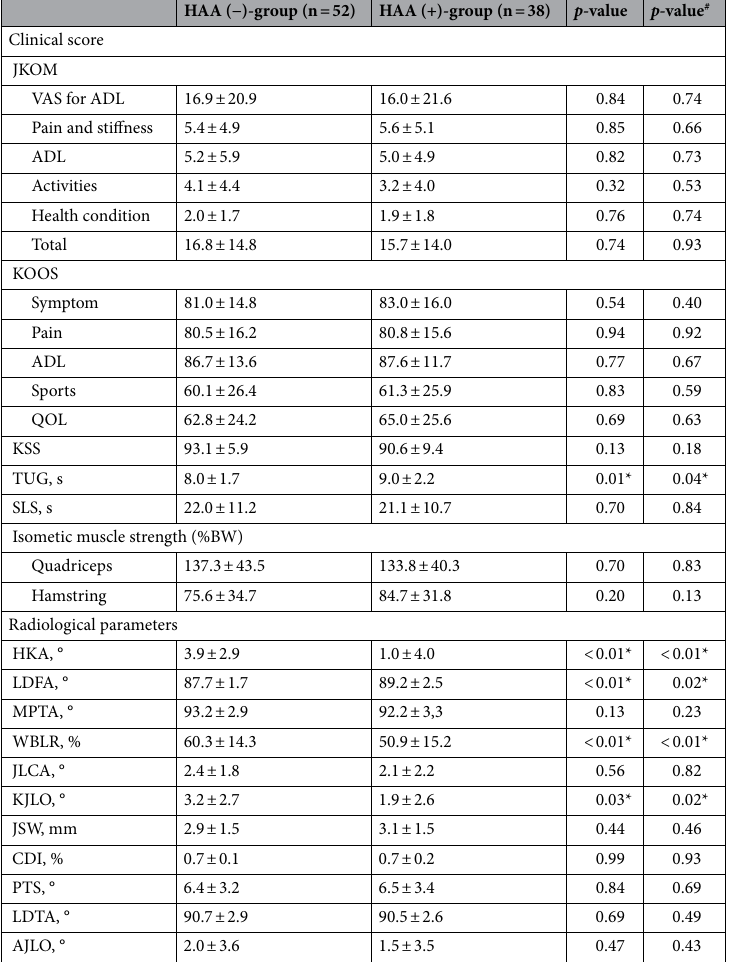
Table 3. Comparison of Clinical and functional score and radiographic parameter between HAA (−) group and HAA (+) group at 2 year post-operation. Data are shown as the means with standard deviation or number. JKOM Japanese Knee Osteoarthritis Measure, VAS visual analogue scale, ADL activities of daily living, KOOS knee injury and osteoarthritis outcome score, QOL quality of life, KSS Knee Society Score, TUG timed up and go test, SLS single leg stance, HAA hip abduction angle, HKA hip-knee-ankle, FTA femoro-tibial angle, WBLR weight-bearing line ratio, JSW joint space width, PTS posterior tibia slope, CDI Caton-Deschamps index, MPTA medial proximal tibial angle, LDFA lateral distal femoral angle, LDTA lateral distal tibial angle, JLCA joint line convergence angle, KJLO knee joint line obliquity, AJLO ankle joint line obliquity. # Adjusted for base line value (ANCOVA models).